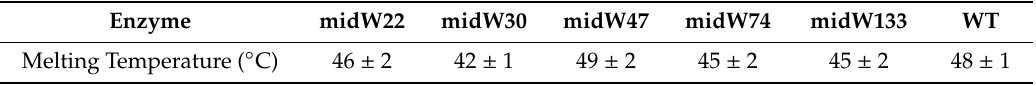
Table 1. Melting temperatures of wild-type (WT) and midW mutants as determined by loss of ellipticity at 222